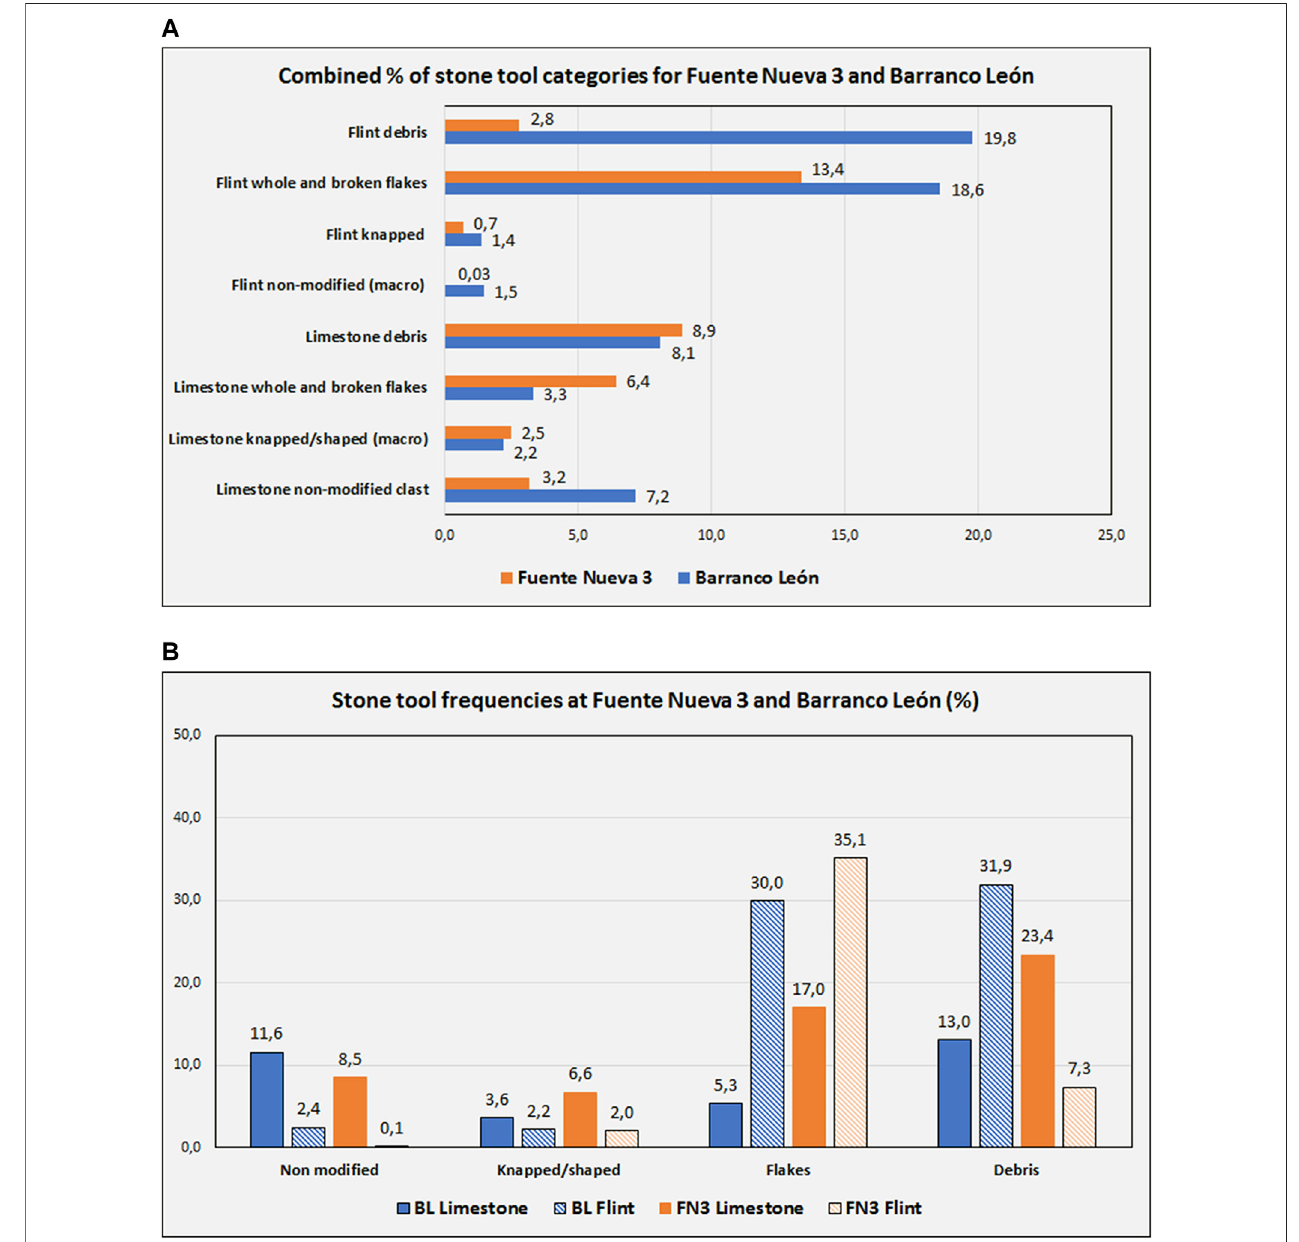
FIGURE 7 | Relative frequency of stone tool categories at Fuente Nueva 3 (FN 3) and Barranco León (BL). (A) The abundance of fl int at BL relative to FN 3 is explained by its presence in the level D1 deposit. At both sites the limestone is well-represented in all categories, while fl int shows higher frequencies among fl akes and debris. The relative scarcity of fl int debris at FN 3 could re fl ect a preference there for better quality fl int. (B) Relative stone tool frequencies in accordance to rock types at BLandFN3.Thelimestoneiswell-representedinallcategoriesanddominatesinthenon-modi fi edandshaped/knappedgroups.Relativefrequenciesof fl int fl akes and debris illustrate the preferential use of this rock for